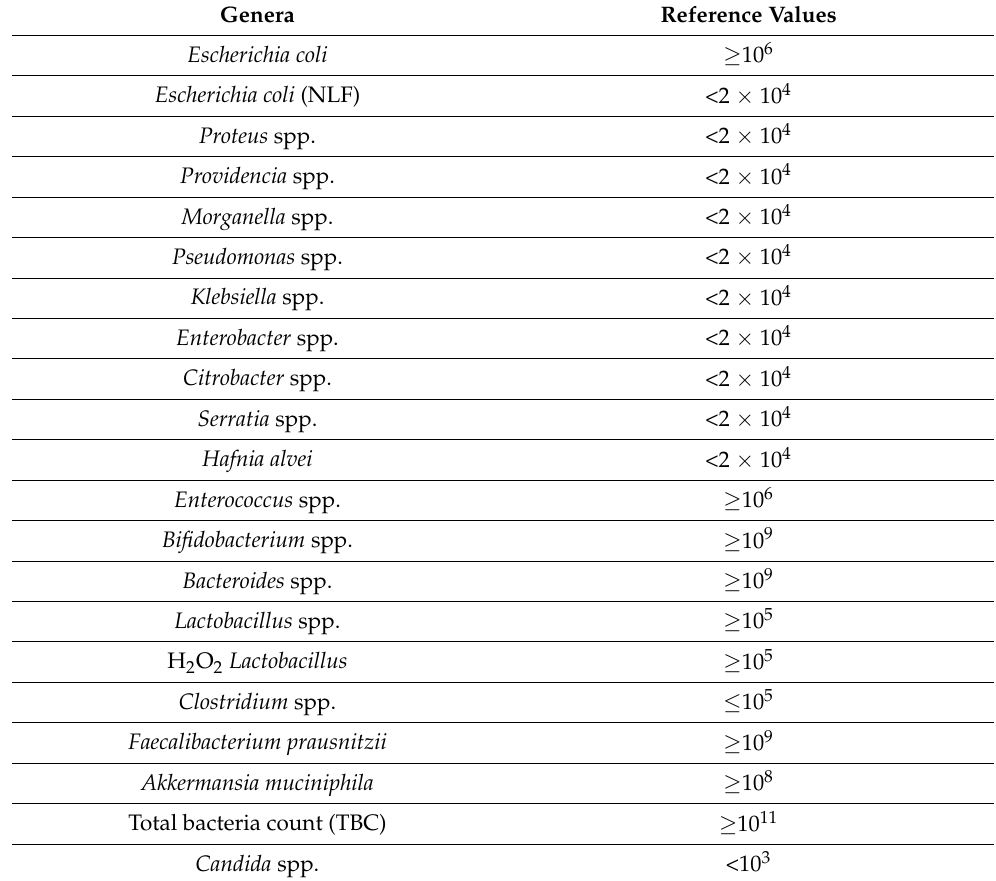
Table 2. Analyzed microorganisms and the reference values according to the Institute of Microecology (Herborn,